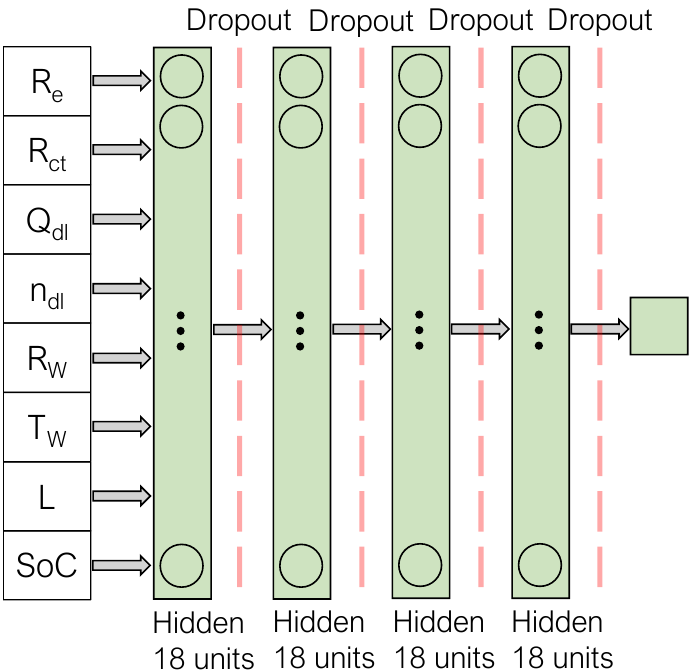
Figure 2. Structure of the baseline artificial neural network (ANN) generated using Bayesian hyperparameter optimisation. State of health is estimated from parameters ( R e , R ct , . . .) extracted from impedance spectra using a modified Randles equivalent circuit model.